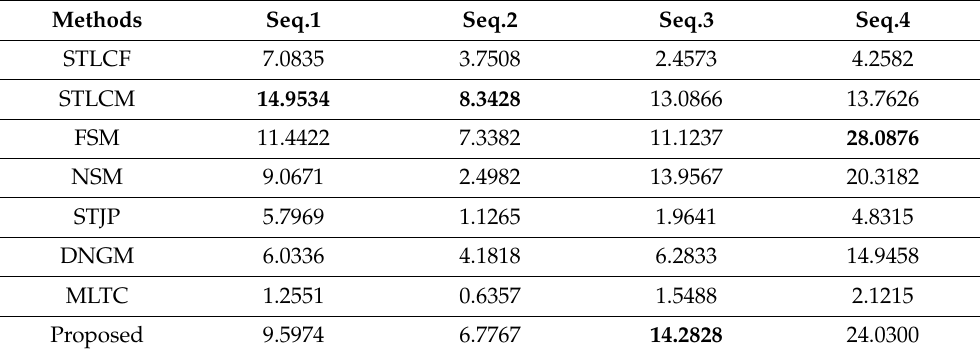
Figure 9. Detection results of different methods in Seq.4. ( a ) raw image, the details of target are magnified at the left bottom corner; ( b ) three-view of raw image; ( c ) result of STLCM; ( d ) result of STLCF; ( e ) result of FSM; ( f ) result of NSM; ( g ) result of STJP; ( h ) result of DNGM; ( i ) result of MLTC; ( j ) result of LSM. Table 2. Average BSF values of different methods for four sequences.